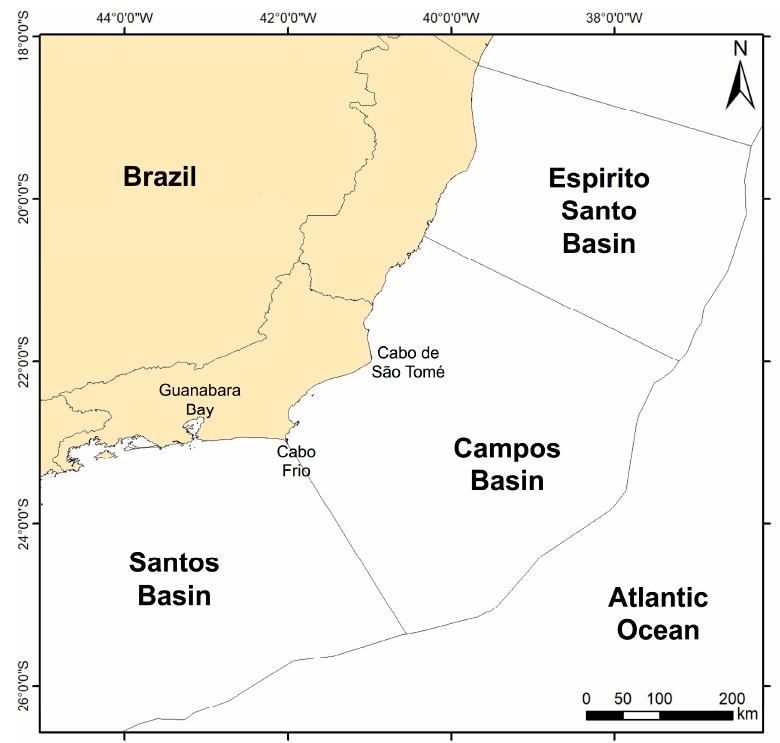
Figure 1. Study area located off the southeast coast of Brazil: the Campos Basin. Courtesy of Cristina Bentz (Petrobras).